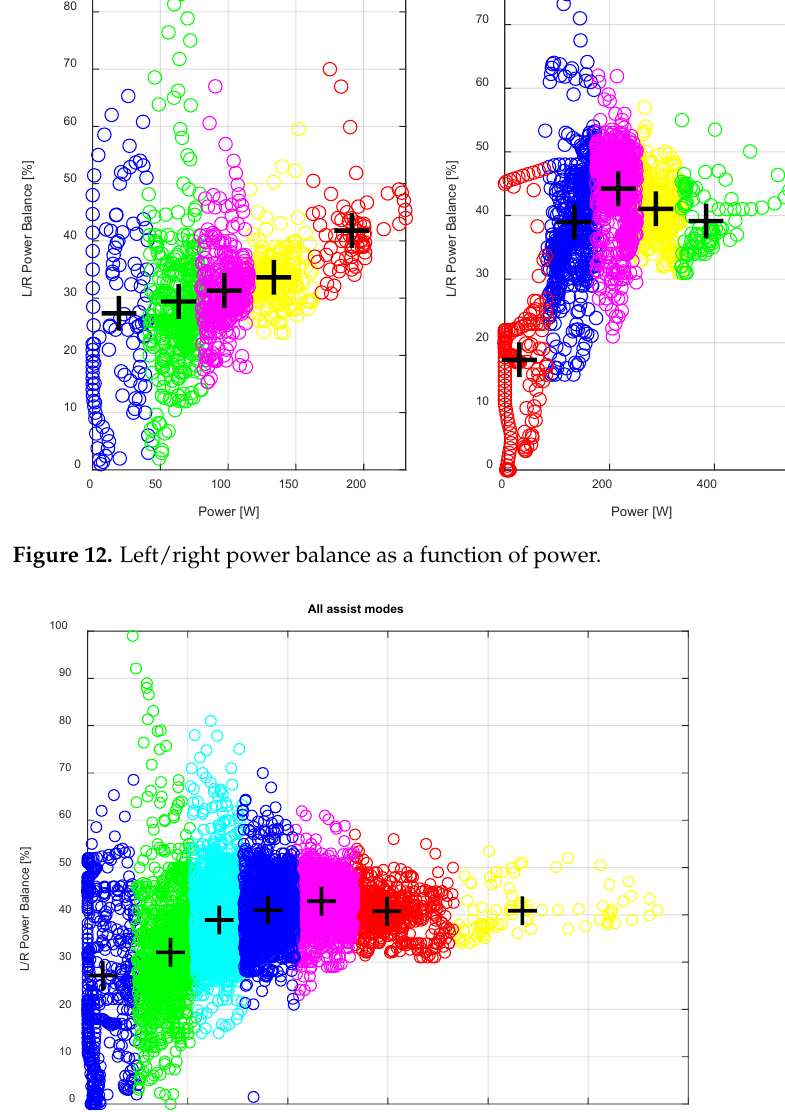
Figure 13. Left/right power balance as a function of power for all modes simultaneously.